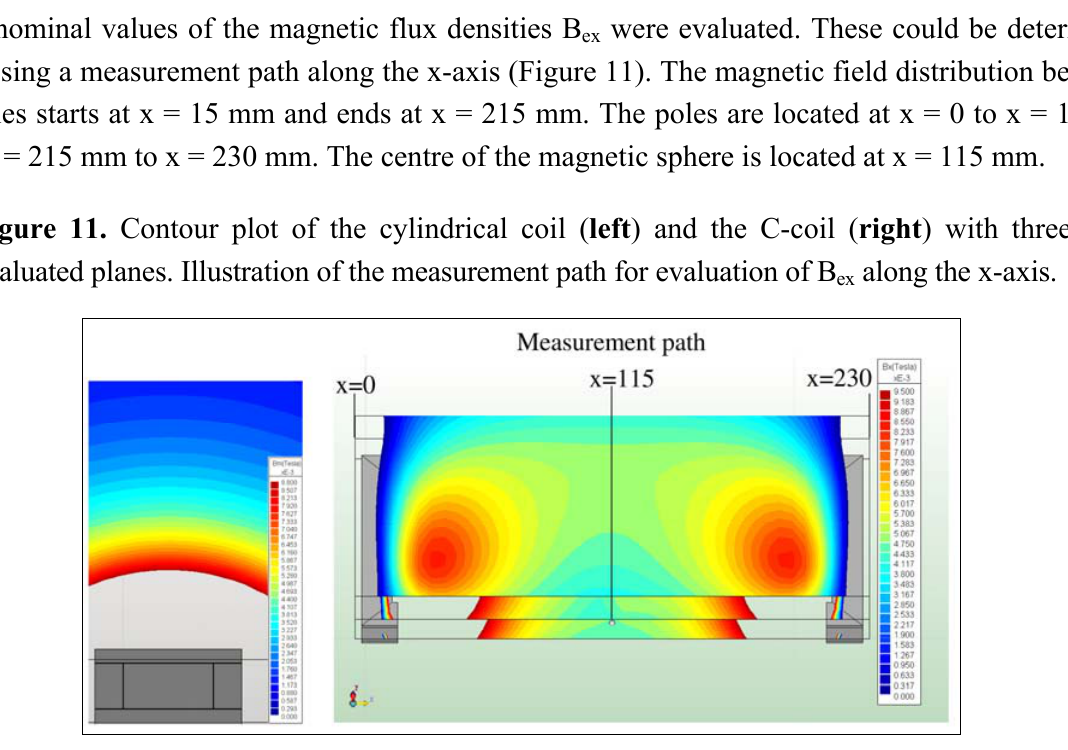
Figure 11. Contour plot of the cylindrical coil ( left ) and the C-coil ( right ) with three evaluated planes. Illustration of the measurement path for evaluation of B